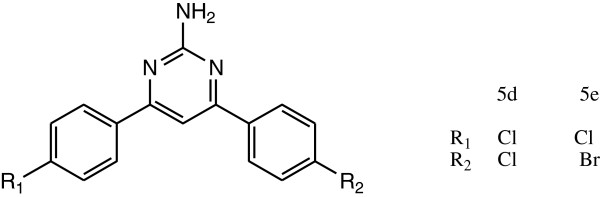
Compounds 5d and 5e.